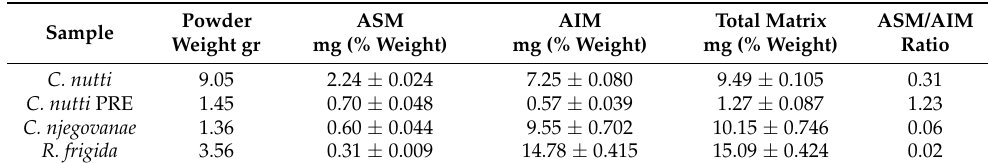
Table 4. Quantification of powder weight (g), ASM and AIM, total matrix (% weight ± s.d.) and ASM/AIM extracted from Cellarinella nutti , C. nutti PRE, Cellarinella njegovanae and Reteporella frigida skeletons. ASM: Acid-soluble matrix. AIM: Acid-insoluble matrix. PRE = pre-bleached.